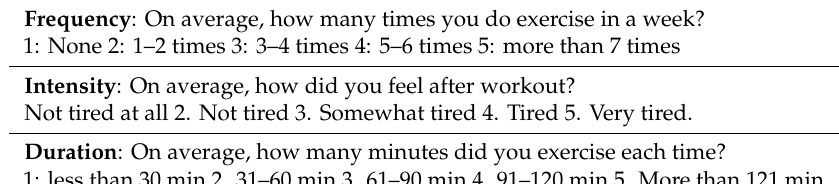
Table A4. Measurement of level of exercise